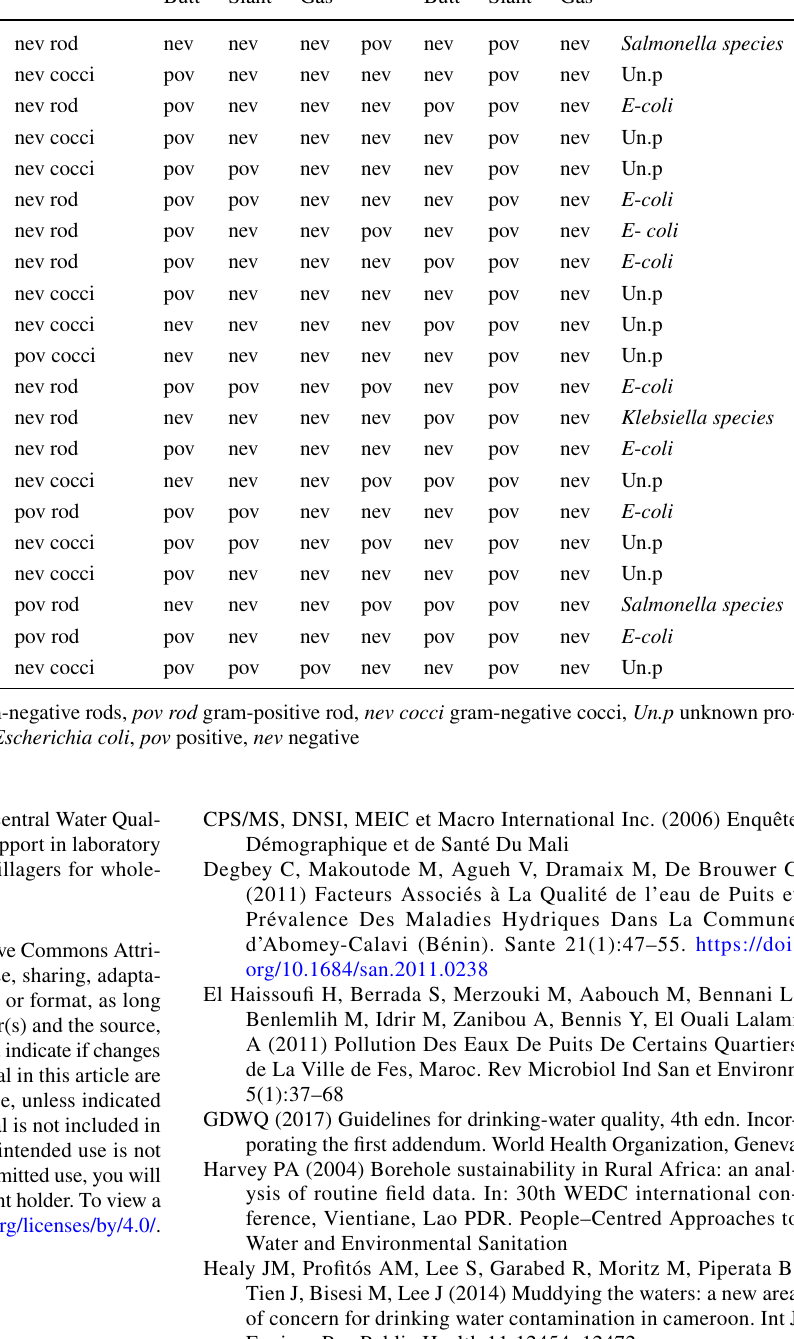
Table 4 The preliminary identification assay findings for presumptive coliform microorganism isolates with Endo’s medium agar and biochemical